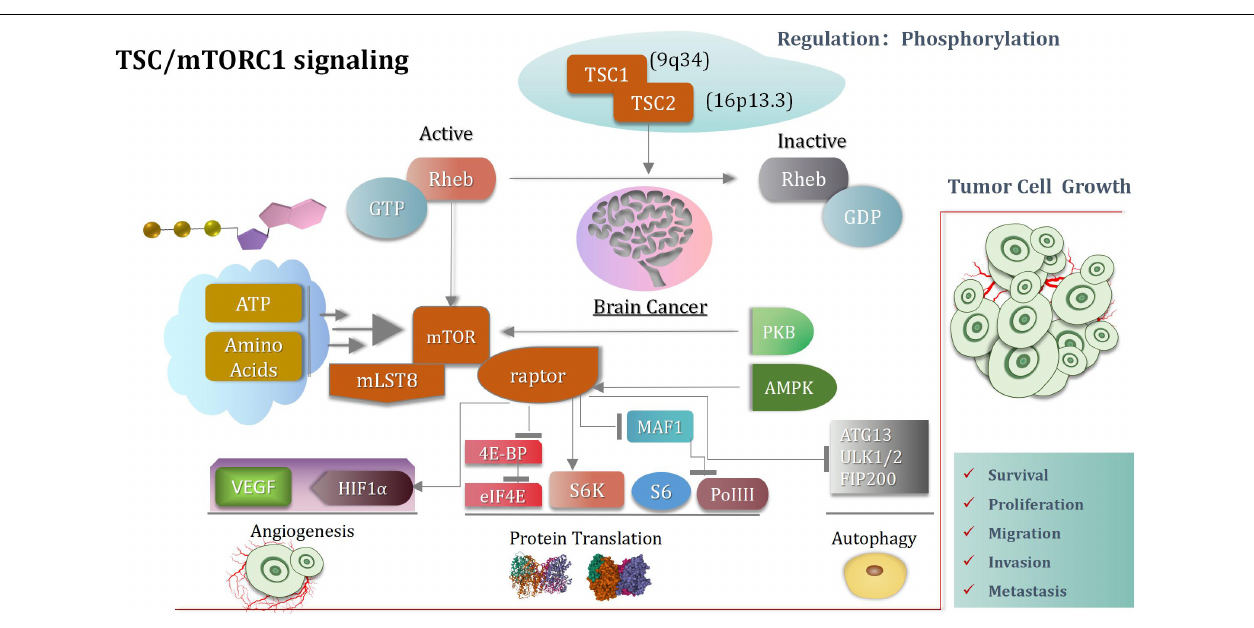
FIGURE 3 | TSC-mTORC1 signaling